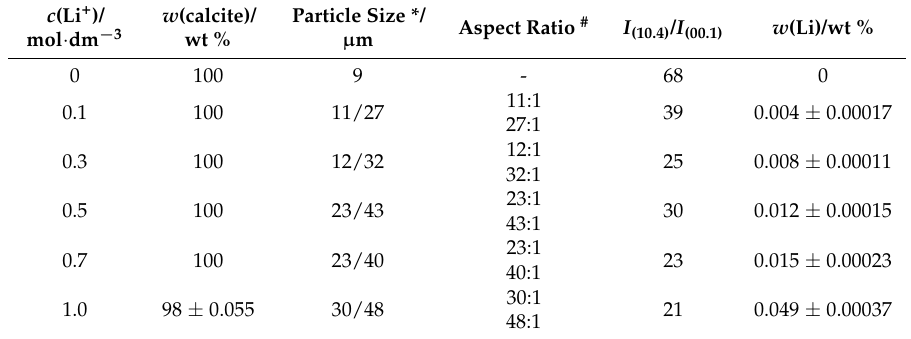
Table 1. Properties of the precipitate and the calcite crystal obtained after initial sonication and 5 days of aging in mother solutions, containing different concentrations of Li + ions. In the system with